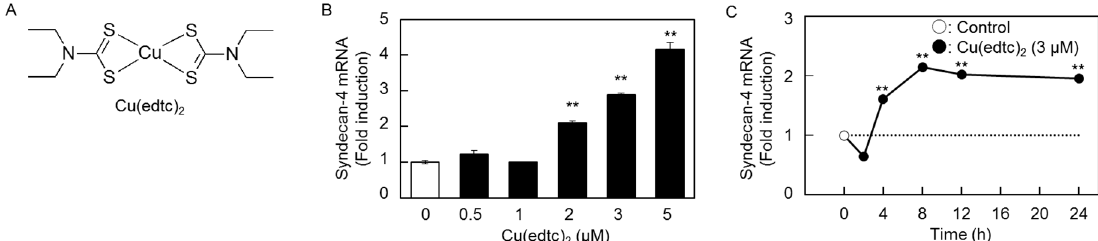
Figure 1. Induction of syndecan-4 mRNA by Cu(edtc) 2 treatment in vascular endothelial cells. ( A ) The structure of Cu(edtc) 2 . The expression of syndecan-4 mRNA; the cells were incubated at 37 °C ( B ) for 8 h in the presence of Cu(edtc) 2 (0.5, 1, 2, 3, and 5 µM) or ( C ) for 2, 4, 8, 12, and 24 h in the presence of Cu(edtc) 2 (3 µM). Syndecan-4 mRNA levels were then determined by real-time reverse transcription polymerase chain reaction (RT-PCR). Values are means ± S.E. of four replicates. ** p < 0.01 vs. the corresponding control.